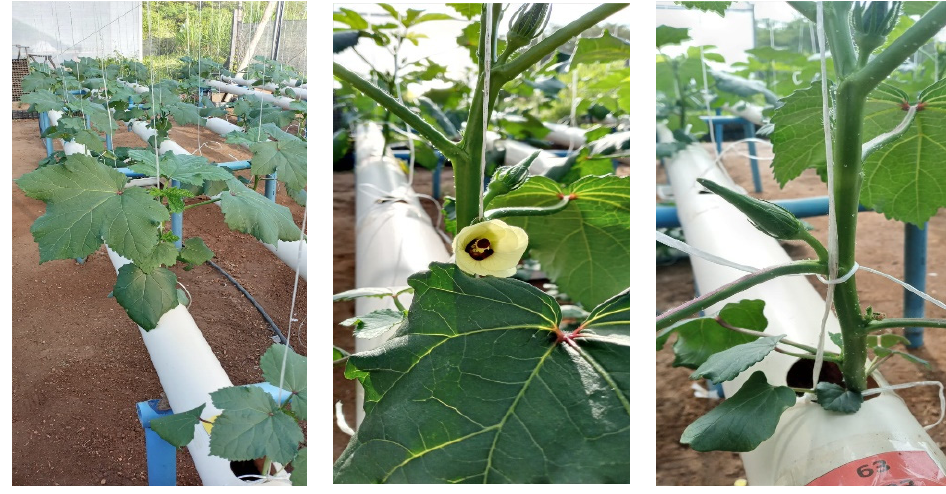
Figure 2. Cultivation of okra in Nutrient Film Technique—NFT hydroponic system at different stages of development.